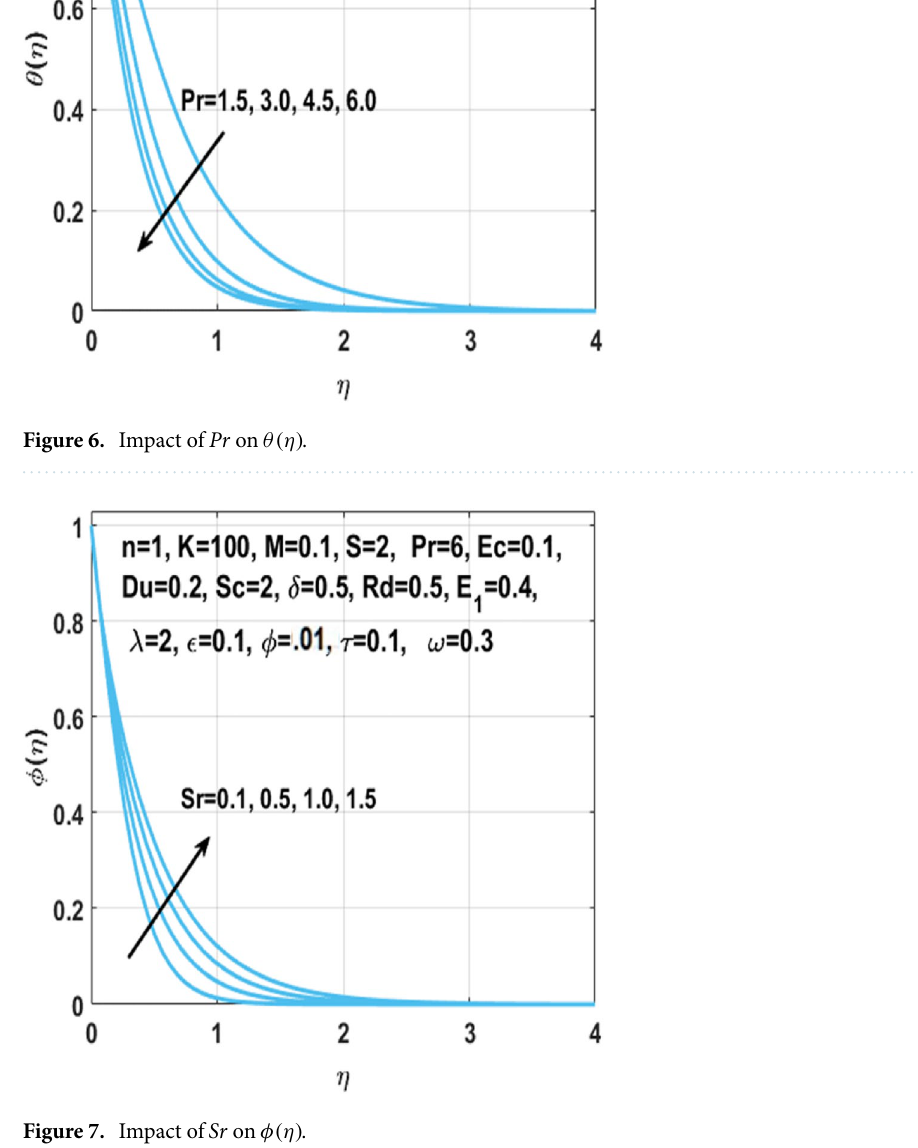
Figure 7. Impact of Sr on φ(η)